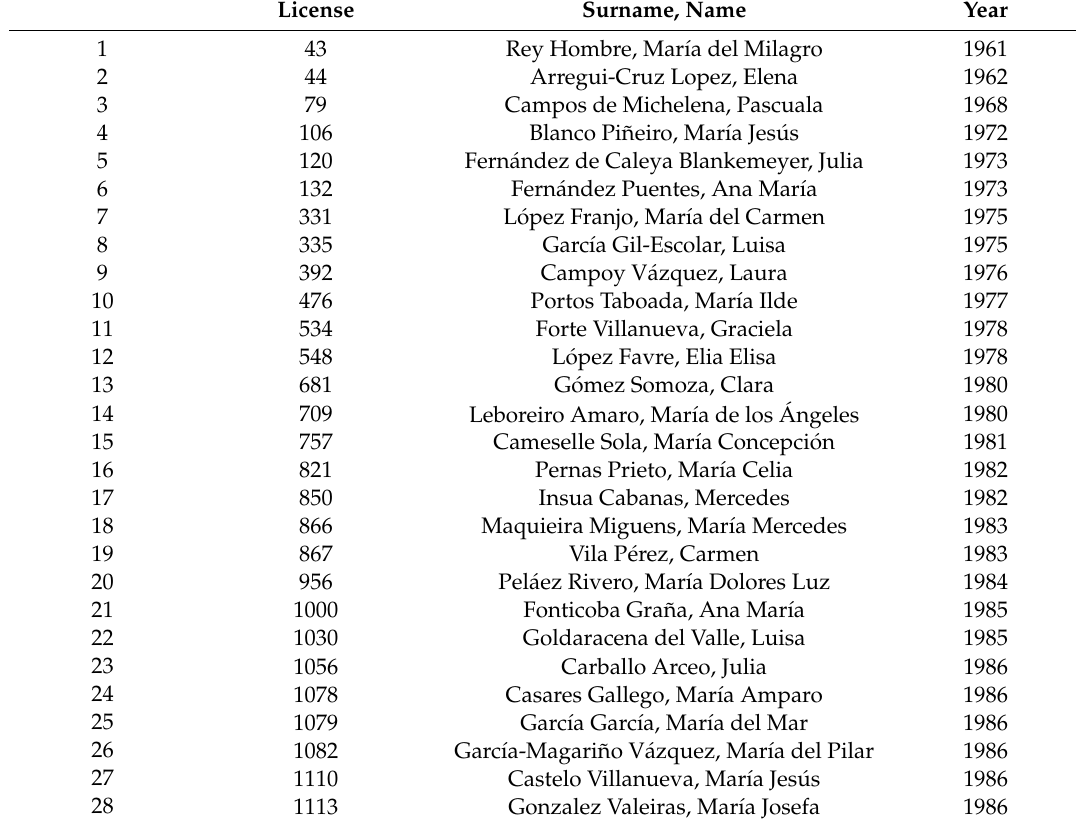
Table A2. Female architects registered in the Galician Association of Architects